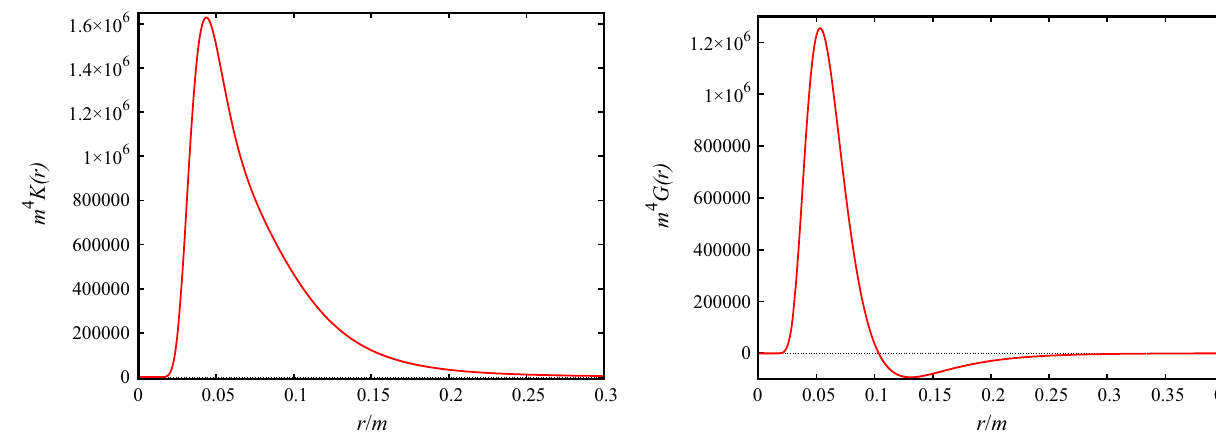
Fig. 12 Kretschmann scalar and Gauss–Bonnet invariant for the Culetu solution for q = 0 . 7 m